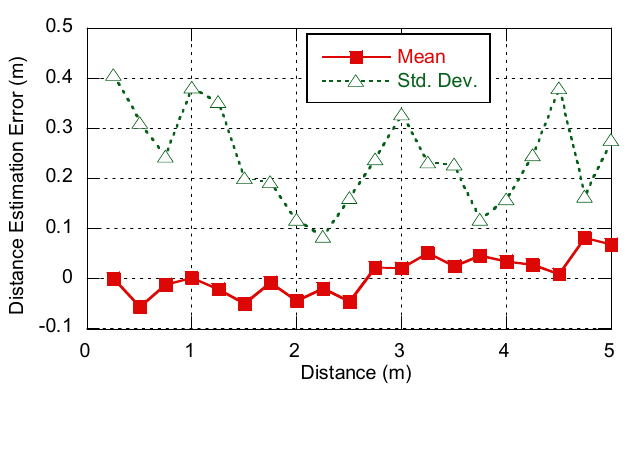
Figure 4. Distance estimation